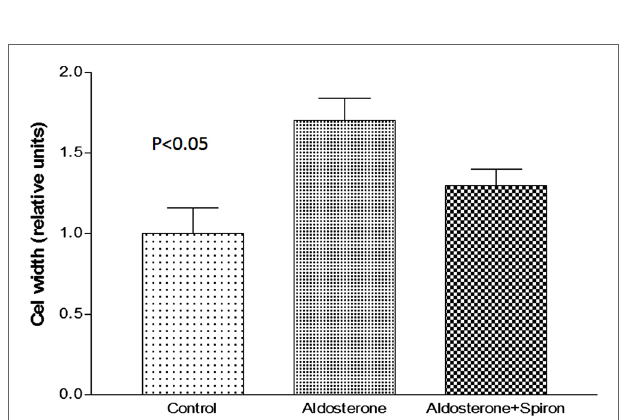
FigUre 3 | spironolactone (100 nM) added to aldosterone (100 nM) solution reduced the effect of aldosterone on the intercellular flow of glucose . Each point is the average from 26 cell pairs. Vertical line at each point SEM ( P <